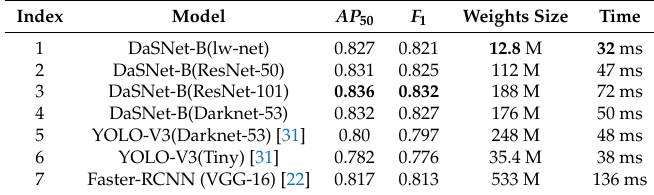
Table 4. Experiment of prediction performance on validation set (640 × 480) with